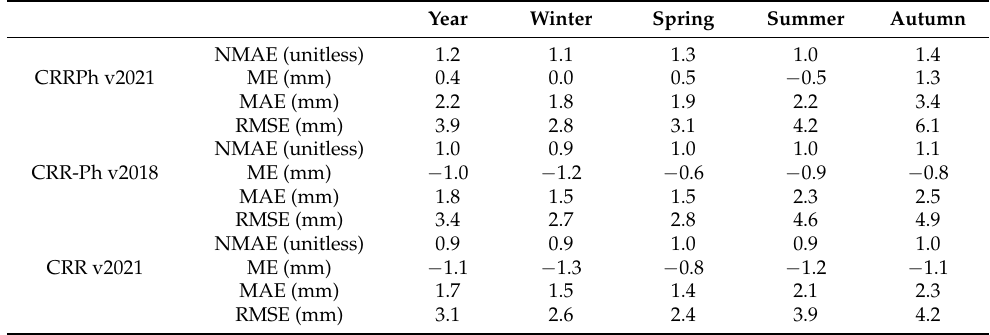
Table 7. Nighttime error statistics for CRRPh v2021, CRR-Ph v2018, and CRR